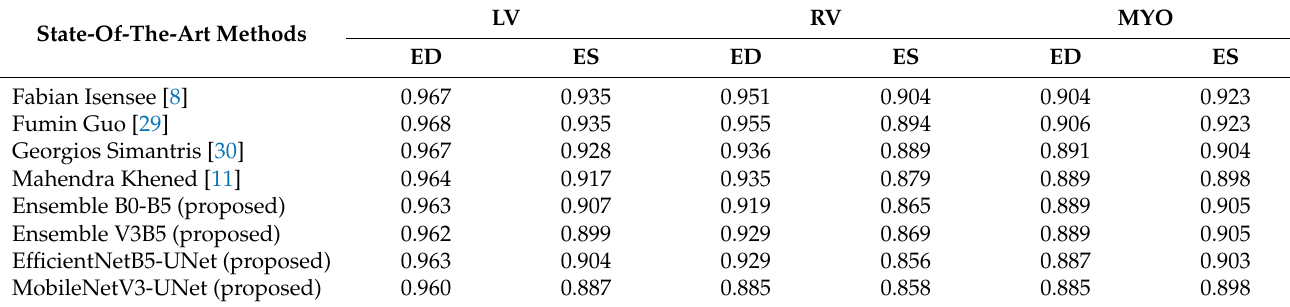
Table 2. Segmentation on test leaderboard with the Dice coefficient.